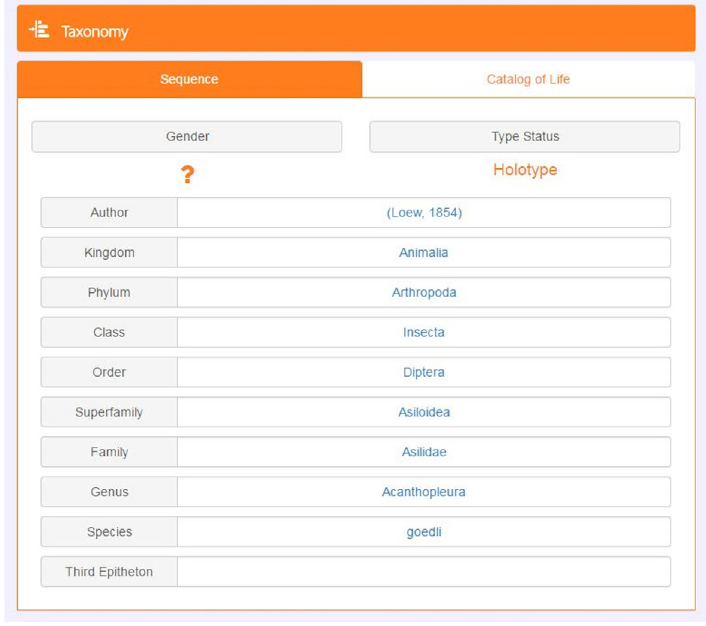
Fig. 2.24. Plane 3 of the specimen page at Zoosphere.net, showing the taxonomy of the specimen. Image copyright